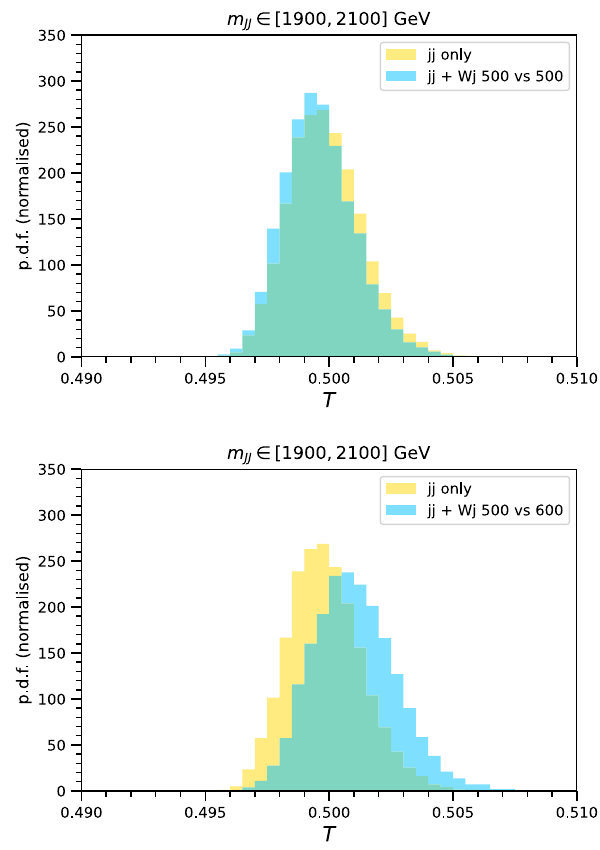
Fig. 16 Probability density functions for the estimator T , obtained when the two samples are drawn from the QCD jet pools (yellow) or also including W j events (blue). See the text for